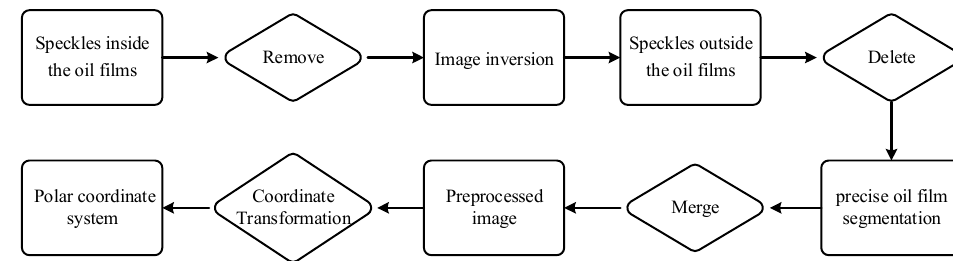
Figure 12. The process of oil spills’ precise identification.